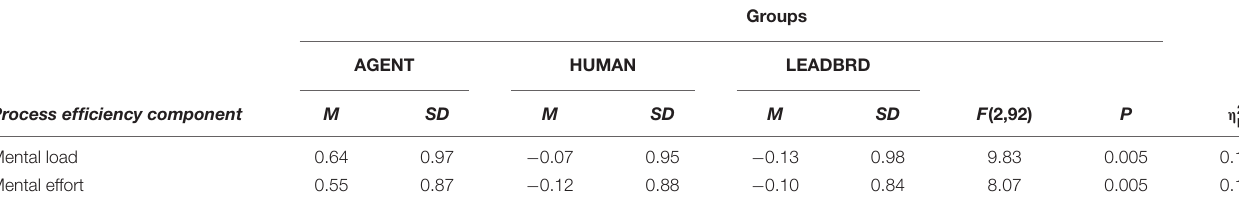
TABLE 5 | Efficiency within the groups.